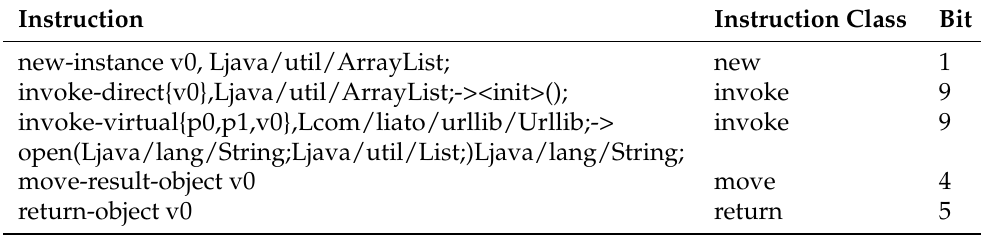
Table 4. Code example and representation in bit for each Instruction.